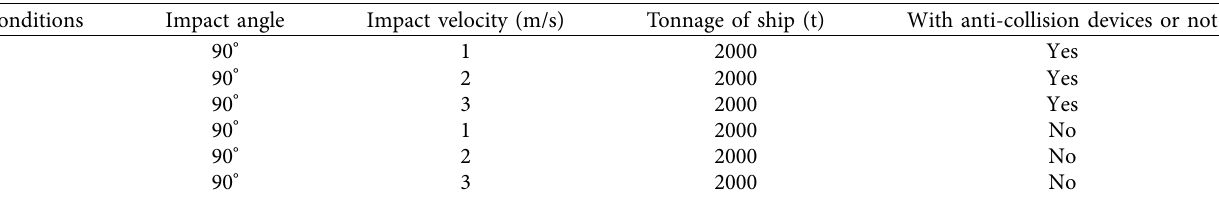
Figure 12: Visualization diagram of calculation data based on BIM model. Table 5: Working conditions of calculating for wind tower.